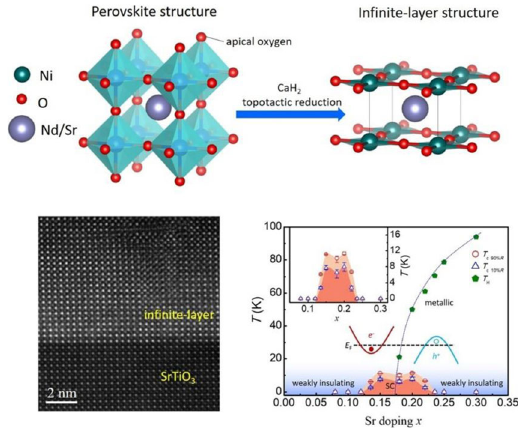
(Top) Figure shows the transformation of the perovsk- ite structure Nd Sr NiO to the infinite-layer structure 1-x x 3 Nd Sr NiO using calcium hydride (CaH ). (Bottom) 1-x x 2 2 Figure shows the high-angle annular dark-field scanning transmission electron microscopy (HAADF-STEM) image and the phase diagram of infinite-layer Nd Sr NiO films on single crystalline SrTiO sub- 1-x x 2 3 strate. The T and T are defined to be the c90%R c10%R temperature at which the resistivity drops to 90% and 10% of the value at 15 K (the onset of the superconduct- ivity) respectively. The inset in the left upper corner of the plot is the enlarged view of the superconducting dome region. T shows the temperature at which the H majority of charge carriers changes from electrons to holes. [Credit: Physical Review